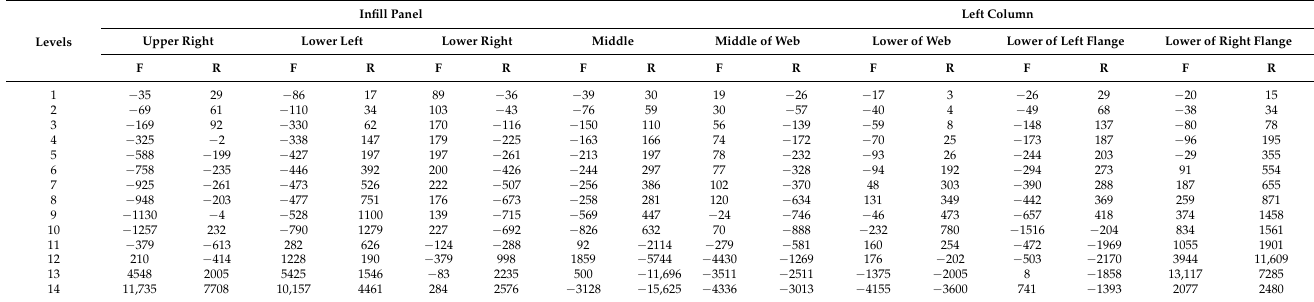
Table 5. Strain values at different locations for specimen 1 at each level of peak load(units: µε